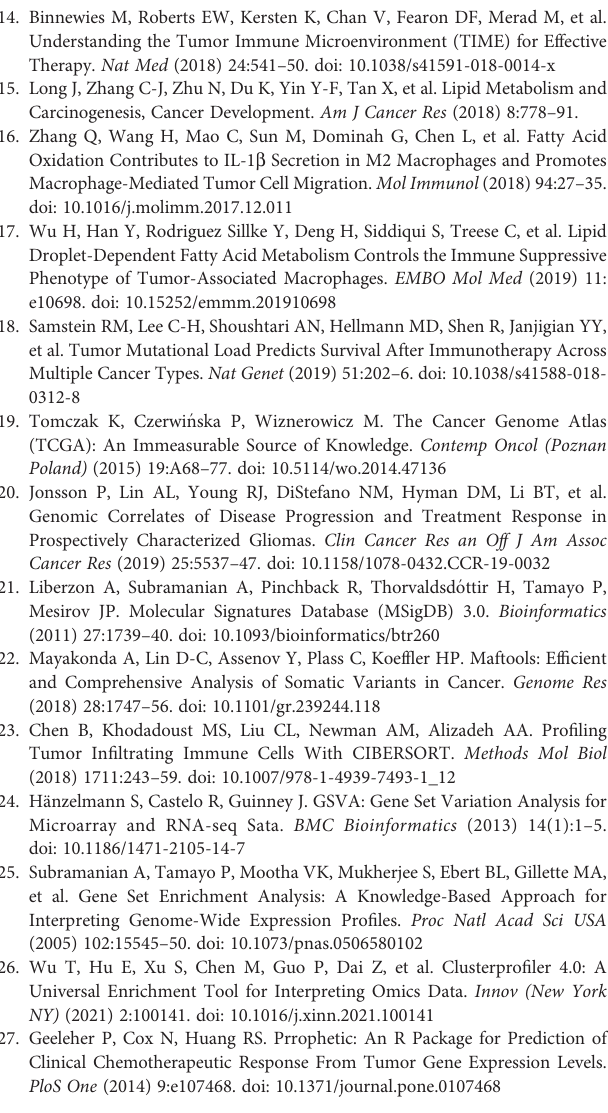
Supplementary Figure 1 | The co-exclusivity and co-occurrence of top 30 mutated driver genes in the fatty acid metabolic processes of the WT (A) and MT (B) groups. MT, mutant-type; WT, wild-type. Supplementary Table 1 | The clinical characteristics of the ICI-GBM